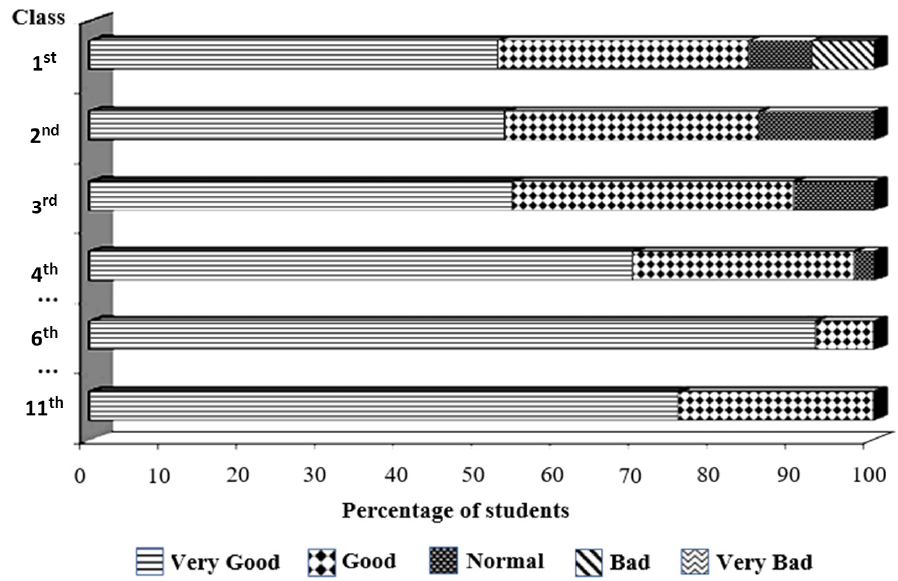
Figure 3. Students’ general evaluation of the classes using the mixed model system, as assessed using brief questionnaires in N3 (2020/21) and N4 (2021/22). In the first class, 8% of students rated the class as “Bad”, and another 8% rated it as “Normal”. By the fourth class, this percentage was reduced to 2%, and, thereafter, students appraised the classes as “Good” or “Very Good”.